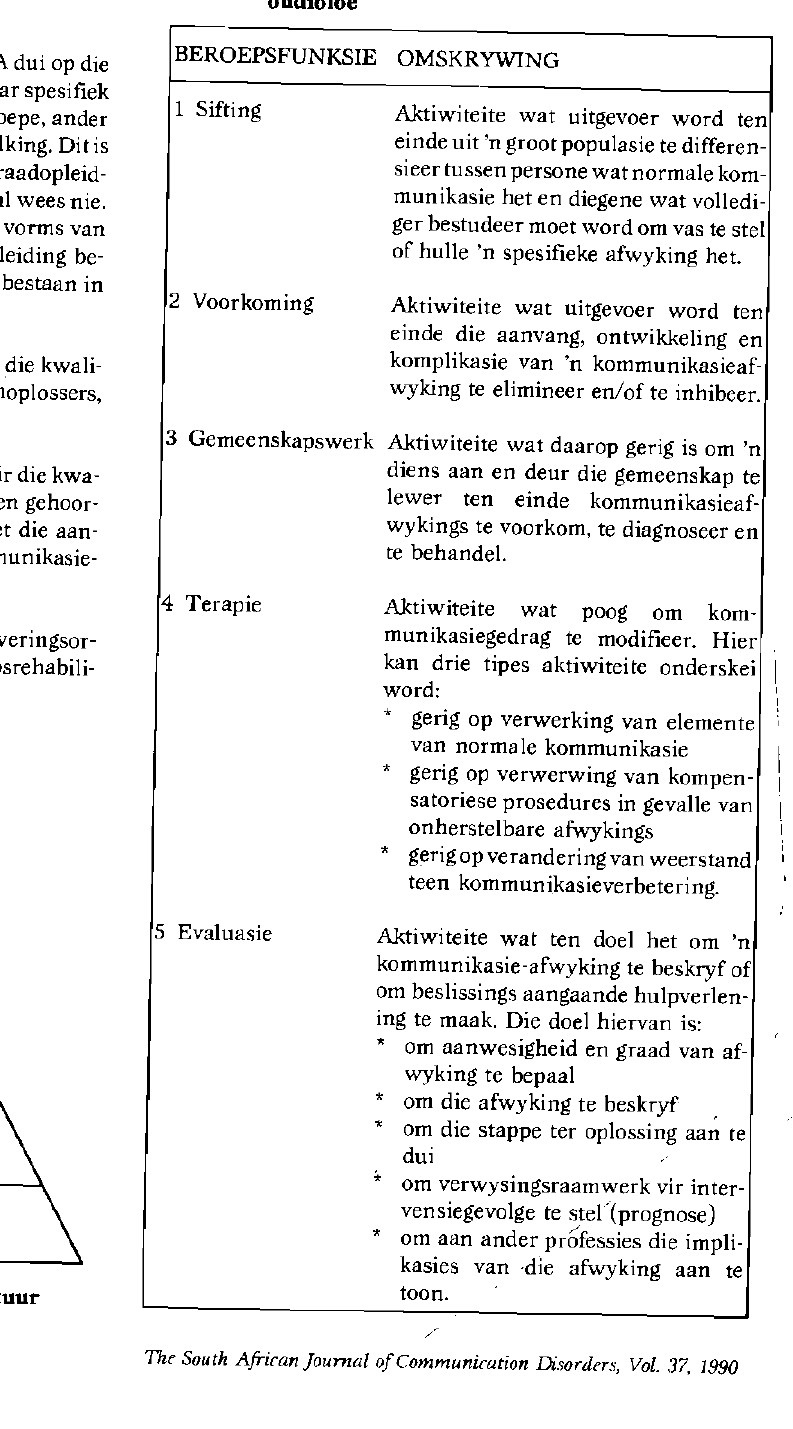
Tabel 1: Beroepsfunksies van spraak-taalterapeute oudioloe